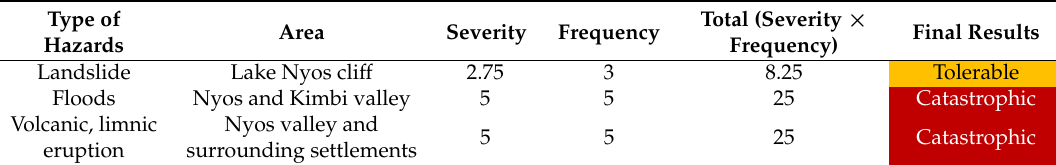
Table 7. Vulnerability index of the main hazards occurring at the lake Nyos before degasing and jet